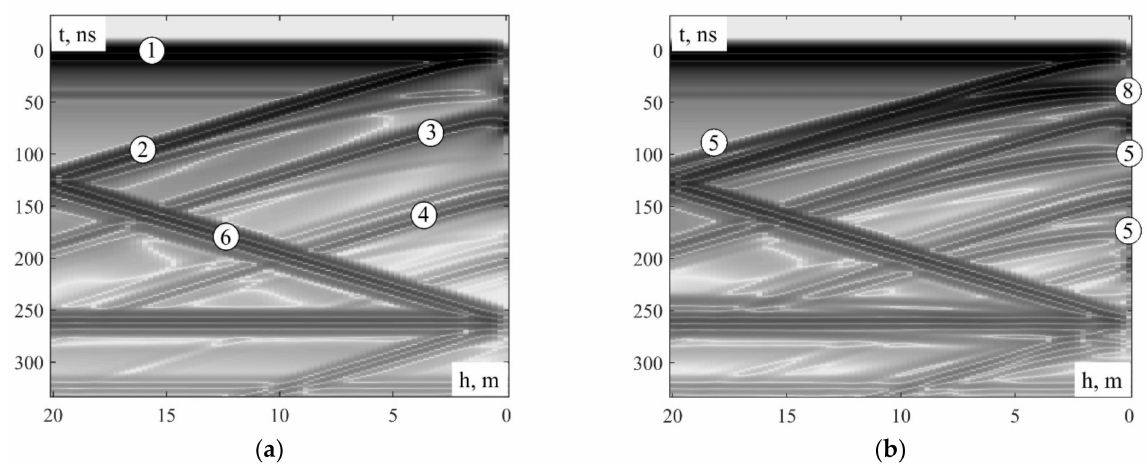
Figure 4. Results of numerical simulation: ( a ) two subsurface layers with thicknesses 2.5 and 4 m respectively; ( b ) two subsurface layers and 3 m high building at a distance of 7 m. Notation: ( 1 ) direct wave; ( 2 ) reflected wave from the ground surface; ( 3 ) reflected wave from the interface at a depth of 2.5 m; ( 4 ) reflected wave from the interface at a depth of 4 m; ( 5 ) reflected wave from the building corner; ( 6 ) reflected wave from the crane jib; ( 8 ) reflected wave from the wall-ground bound line; h means GPR lift height above the